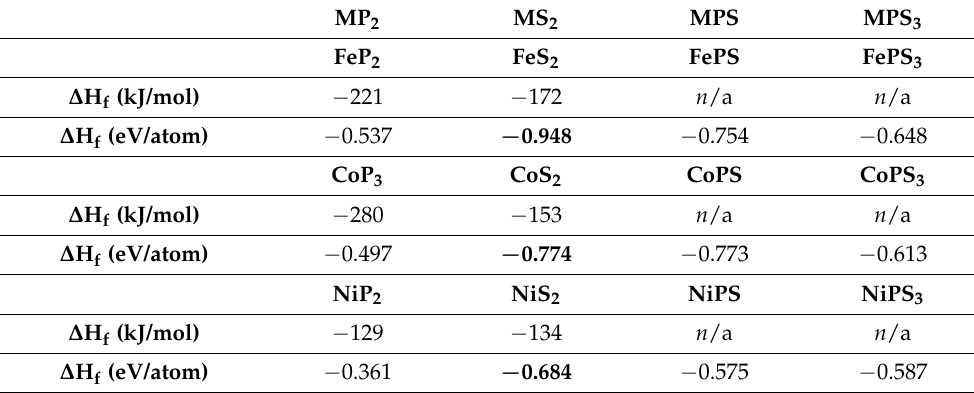
Table 2. Comparison of the standard (298 K) heats of formation and the calculated eV/atom energies for several Fe, Co and Ni phosphides, sulfides, and MPS 3 materials. MP 2 MS 2 MPS MPS 3 FeP 2 FeS 2 FePS FePS 3 ∆ H f